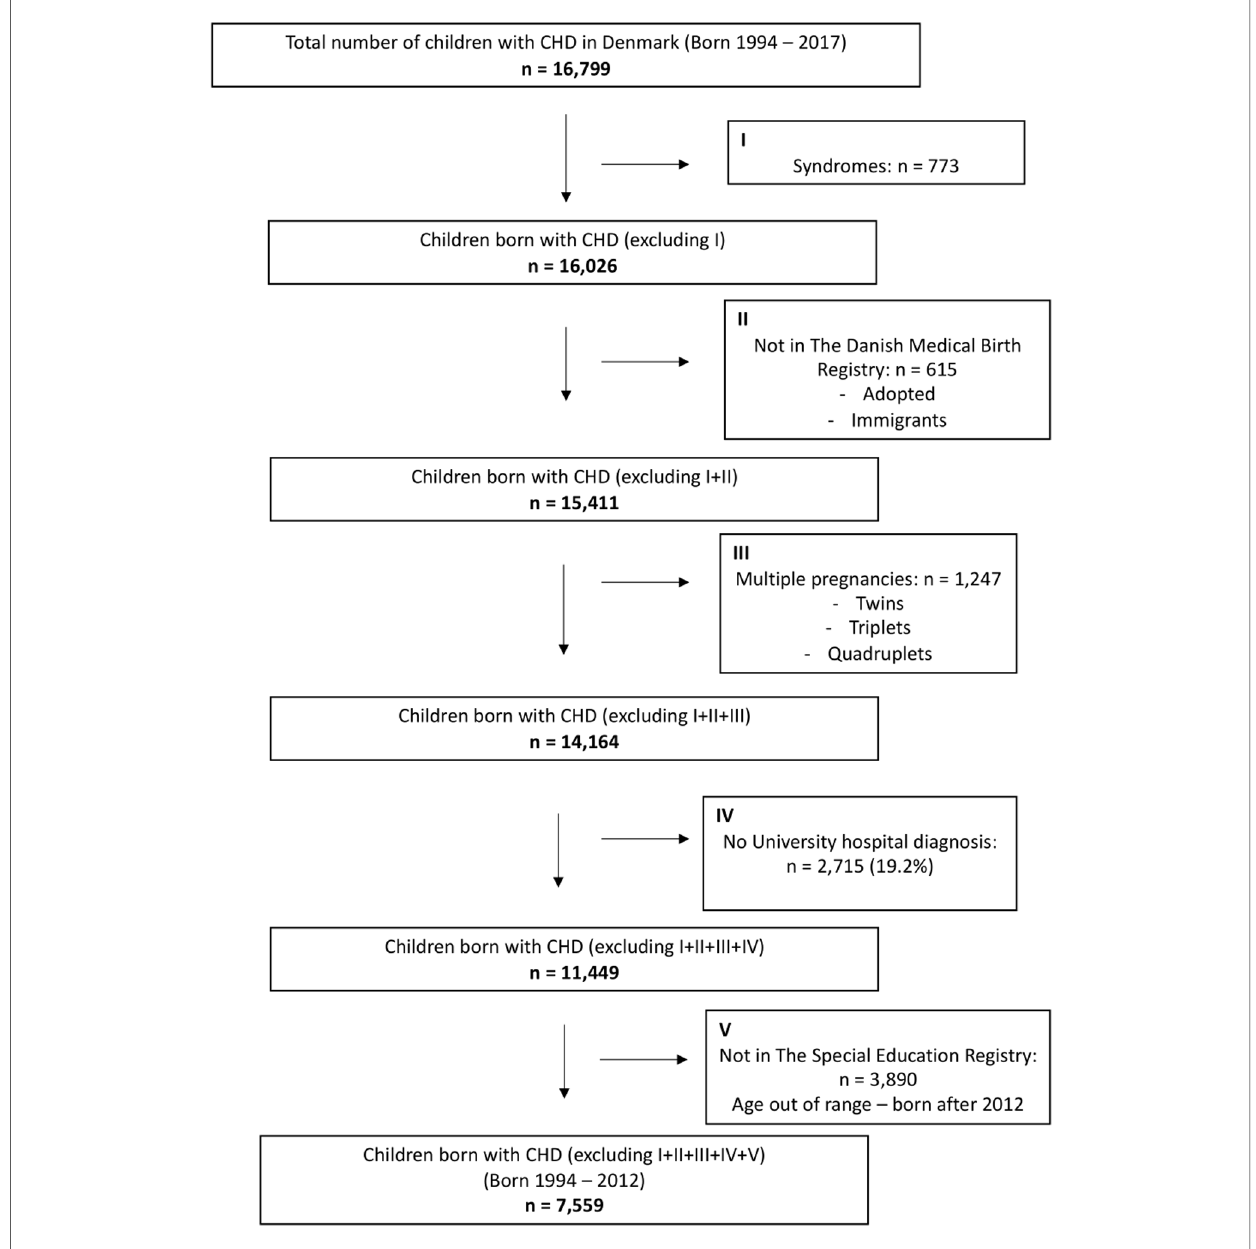
FIGURE 1 Numbers of children born with CHD included in the